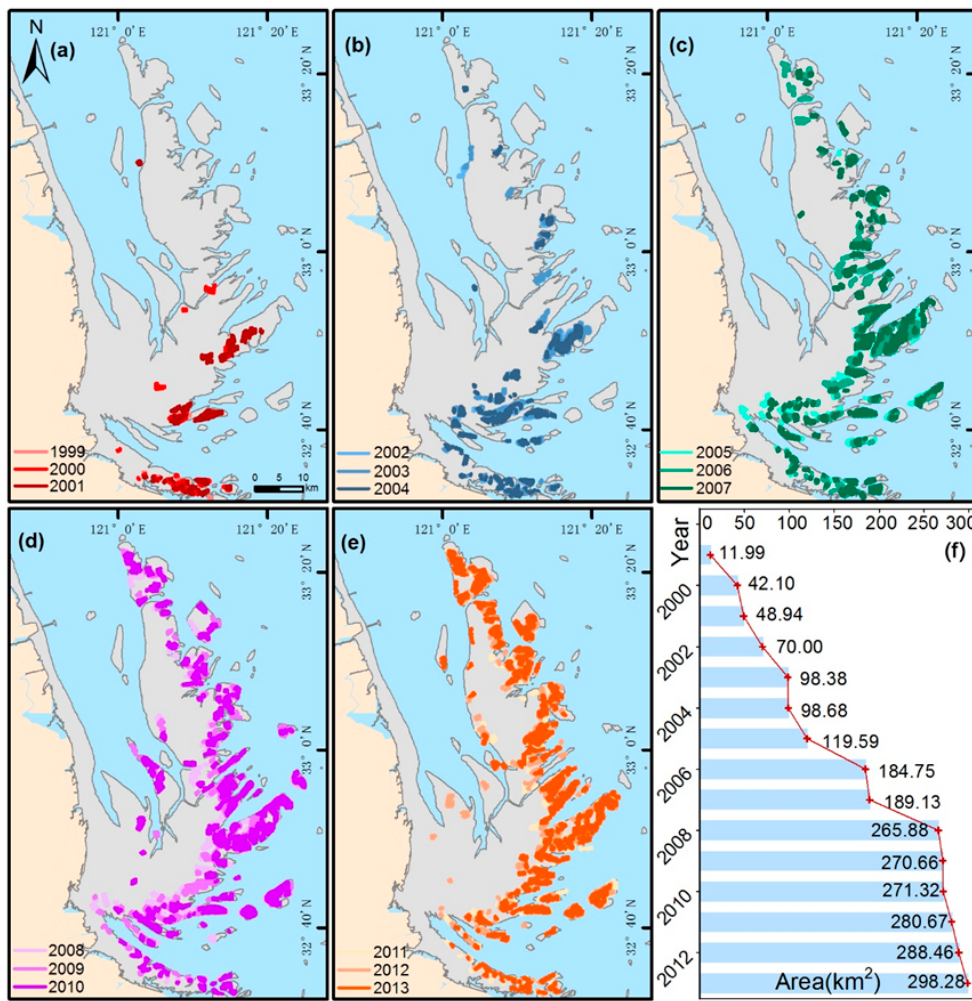
Figure 4. The expansion of the laver aquaculture regions from 1999 to 2013. ( a )–( e ) Spatial distribution of the aquaculture regions and ( f ) the growth curve of the area.